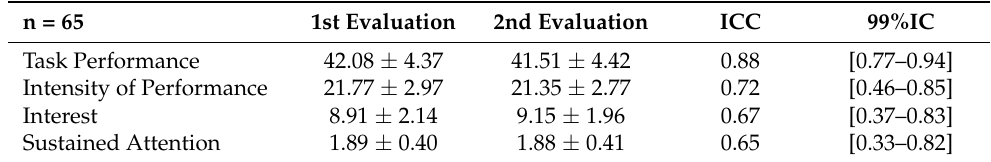
Table 6. Test-retest reliability ICC